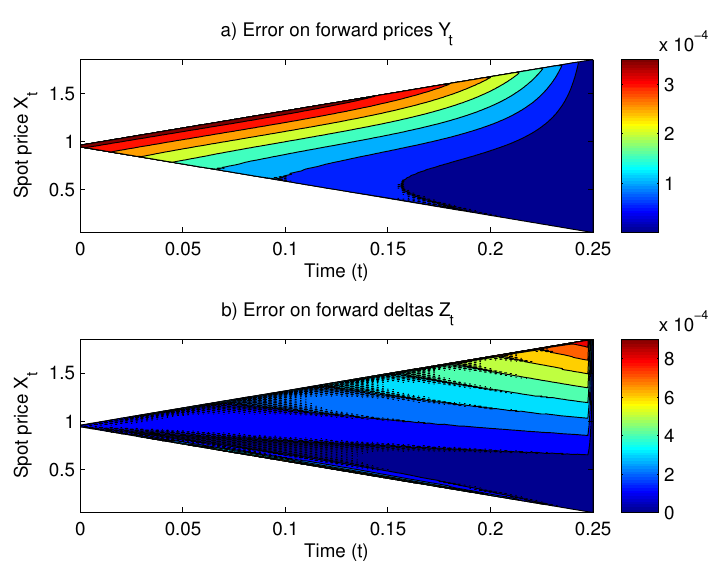
Figure 6. Errors using the 2-stage Runge–Kutta scheme with σ = 0.08. The numerical solution is obtained on a time mesh with n = 100 time steps and returns an forward price of 1.0115 and initial value of 0.0558 for the control process. The exact values are 1.0119 and 0.0556, respectively.